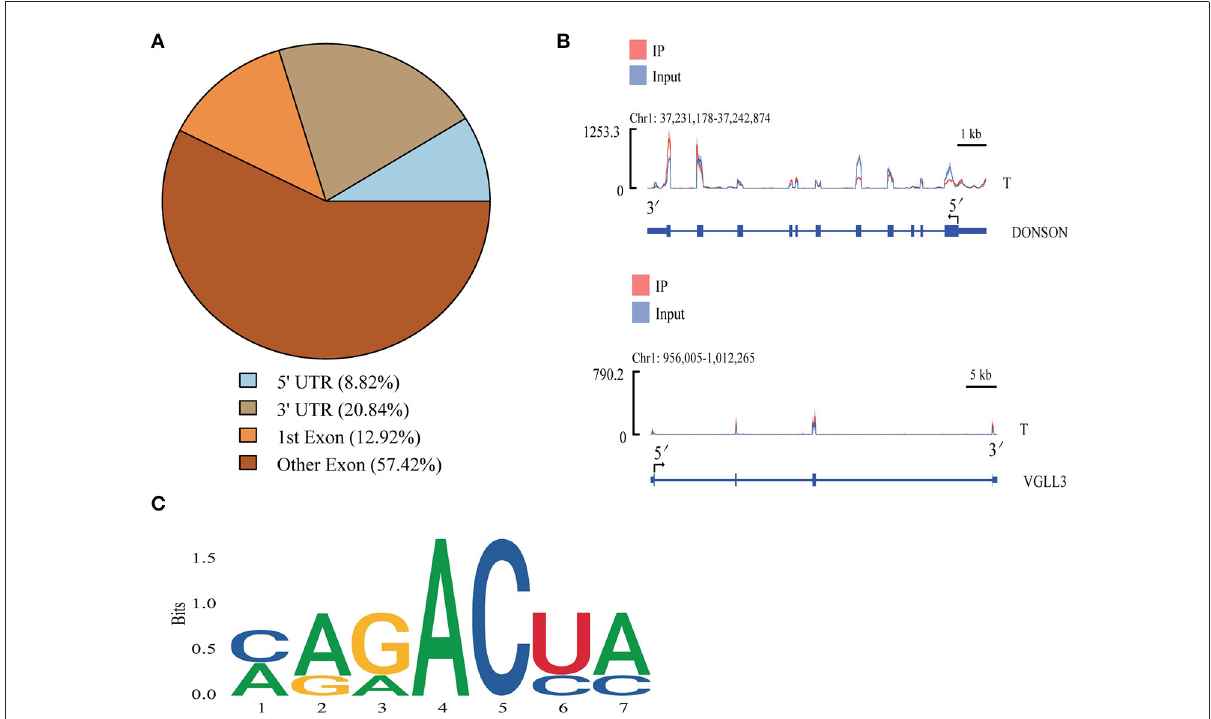
FIGURE3 Cattle-yak methylation peak analyses. (A) mRNA methylation peak distributions. (B) IGV plots demonstrating peaks in the VGLL3 and DONSON genes. (C) The motifs most commonly subjected to m 6 A modification in cattle-yak testicular